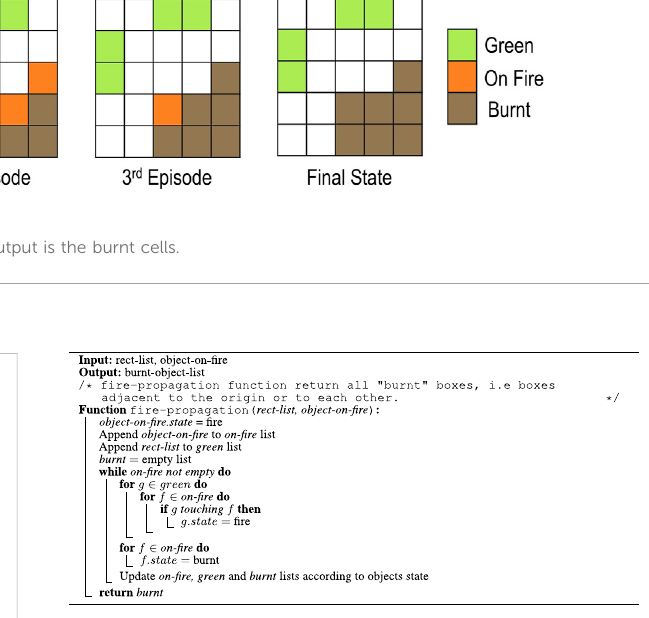
FIGURE 9 Consecutive episodes of the clustering algorithm to group three boxes of text that belong together. t is the